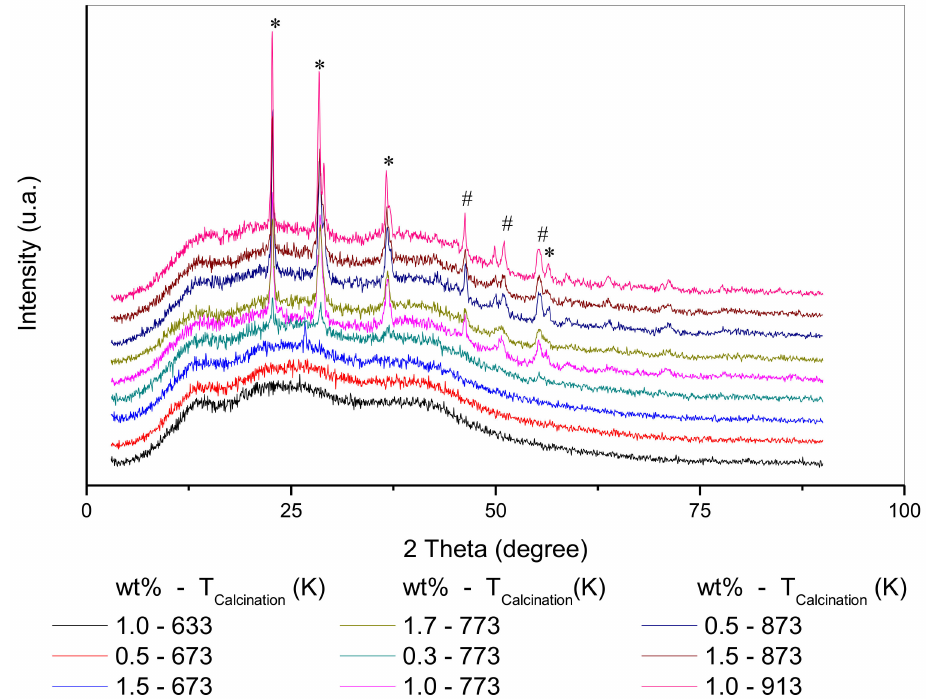
Figure 1. XRD pattern of Fe/Nb 2 O 5 sample where (*) TT phase (pseudo-hexagonal form) (#) T phase (orthorhombic